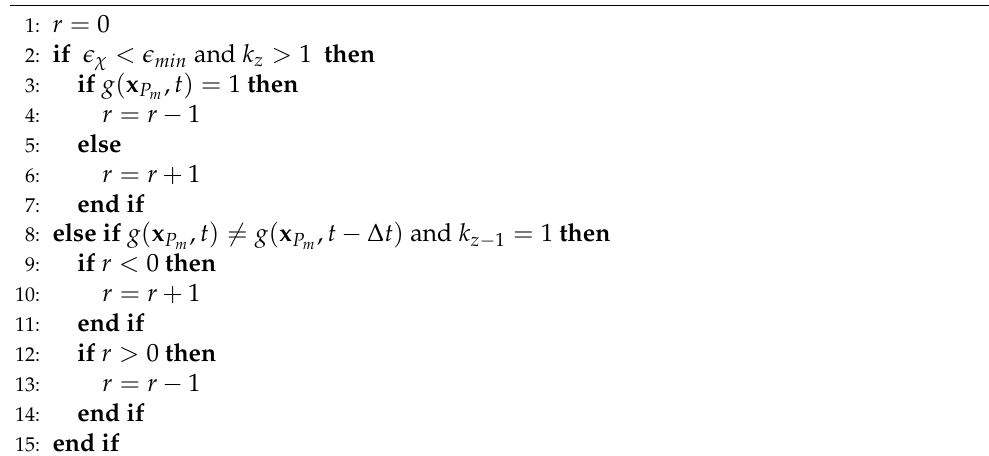
Algorithm 1 Detection of concave parts of boundary and r